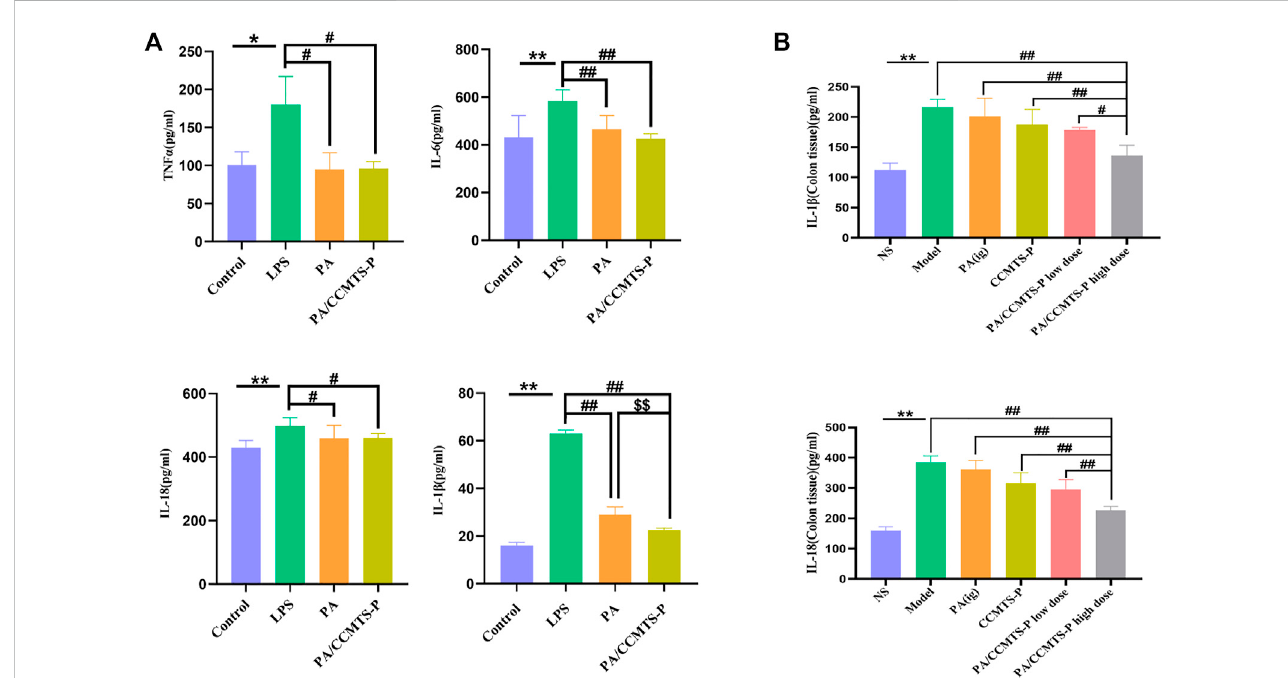
FIGURE 6 PA/CCMTS-Peffectively alleviates in fl ammation both in vivo and in vitro. (A) The expression levels of in fl ammatorycytokinesTNF α , IL-6, IL-18, and IL-1 β in the supernatant of RAW264.7 were measured by ELISA after stimulation with LPS with or without PA and PA/CCMTS-P for 24 h. Data are shown as mean ± SD ( n = 5), * p < 0.05, ** p < 0.01; # p < 0.05, ## p < 0.01; $$ p < 0.01. (B) The expression levels of in fl ammatory cytokines IL-1 β and IL-18 in the colon tissues of DSS-induced UC mice were measured by ELISA. Data are shown as mean ± SD ( n = 3), ** p < 0.01; # p < 0.05, ## p < 0.01.